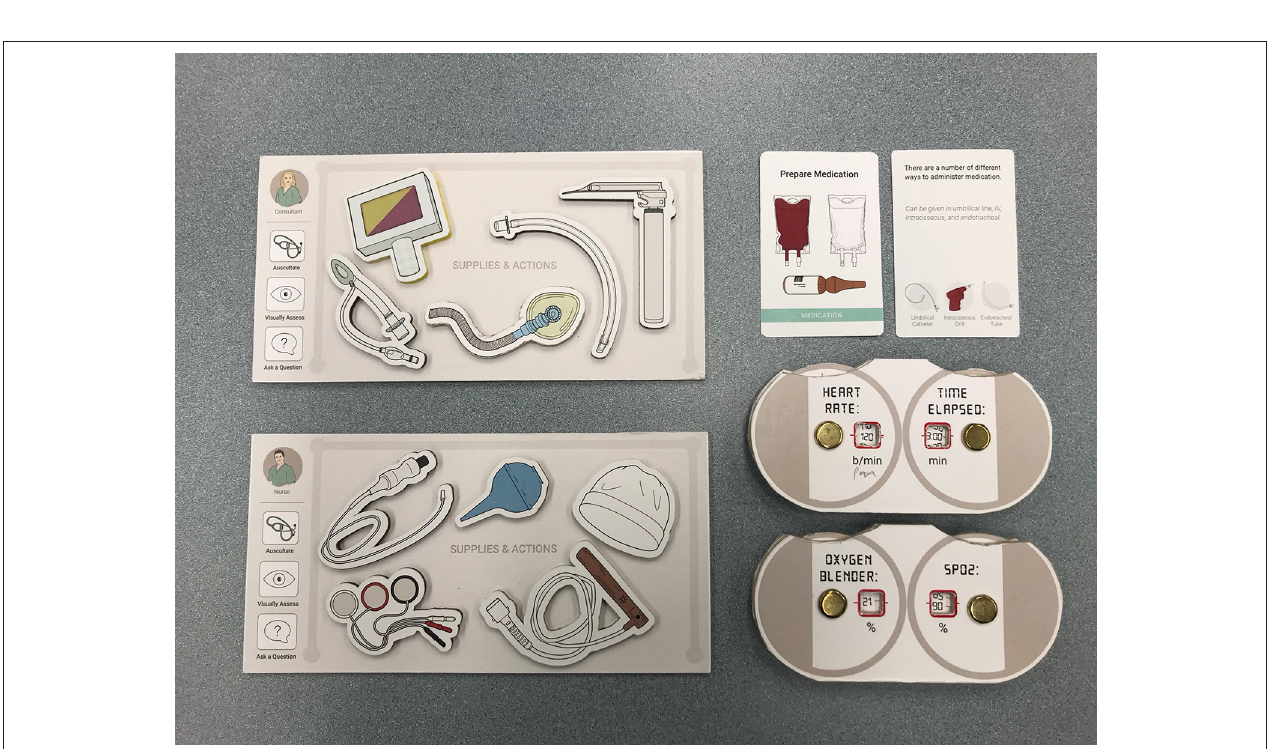
FIGURE 2 | Excerpt of a personal board indicating the player’s role and visual objects, action cards, and adjustable timers and monitors within the board game RETAIN.